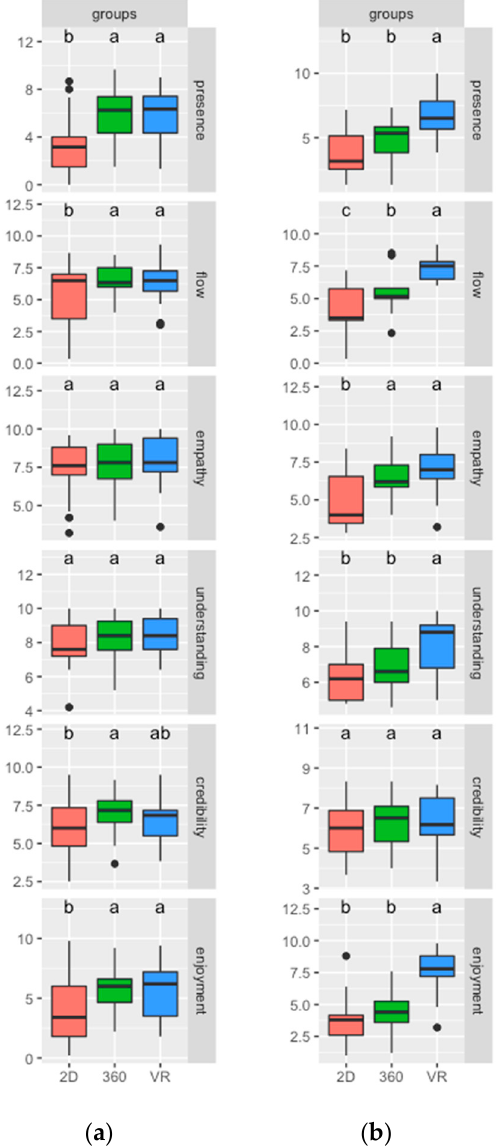
Figure 2. Effect of IVEs on presence, flow, empathy, credibility, understanding, and enjoyment. ( a ) Video 1; ( b ) Video 2